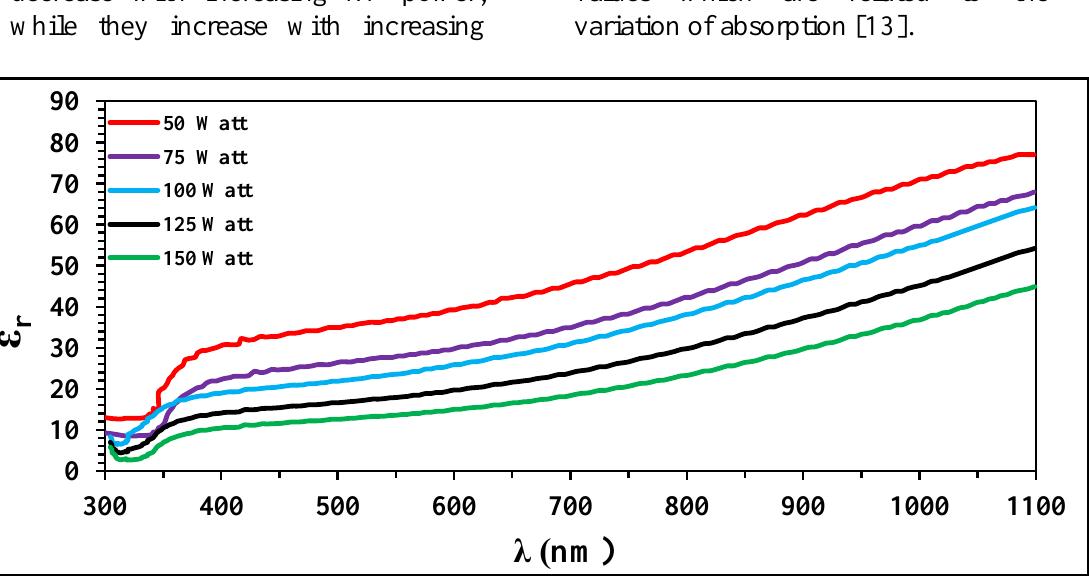
Fig.6: Dielectric constant real as a function of wavelength for (Ti6Al4V) thin film at different working RF